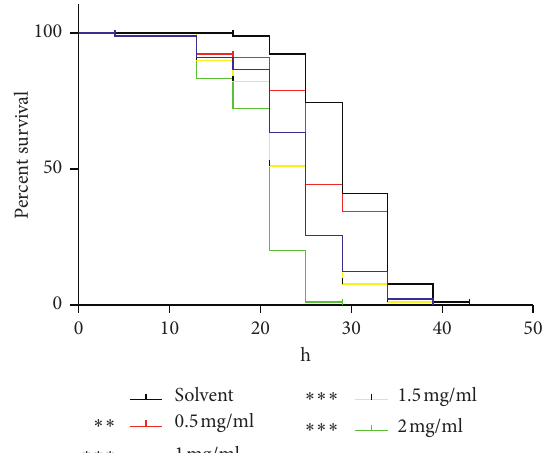
Figure 2: Essential oil of flesh fingered citron affects the oxidative stress resistance of wild-type C. elegans . At least three independent biological replications were performed, and statistical significance of the differences between curves was demonstrated by a log-rank test using Kaplan − Meier survival analysis. Error bars represent the standard error, and differences compared to the solvent (0mg/ml, 0.1% DMSO) were considered significant at ∗ p < 0 . 05, ∗∗ p < 0 . 01, and ∗∗∗ p < 0 . 001 by one-way ANOVA and the LSD post hoc